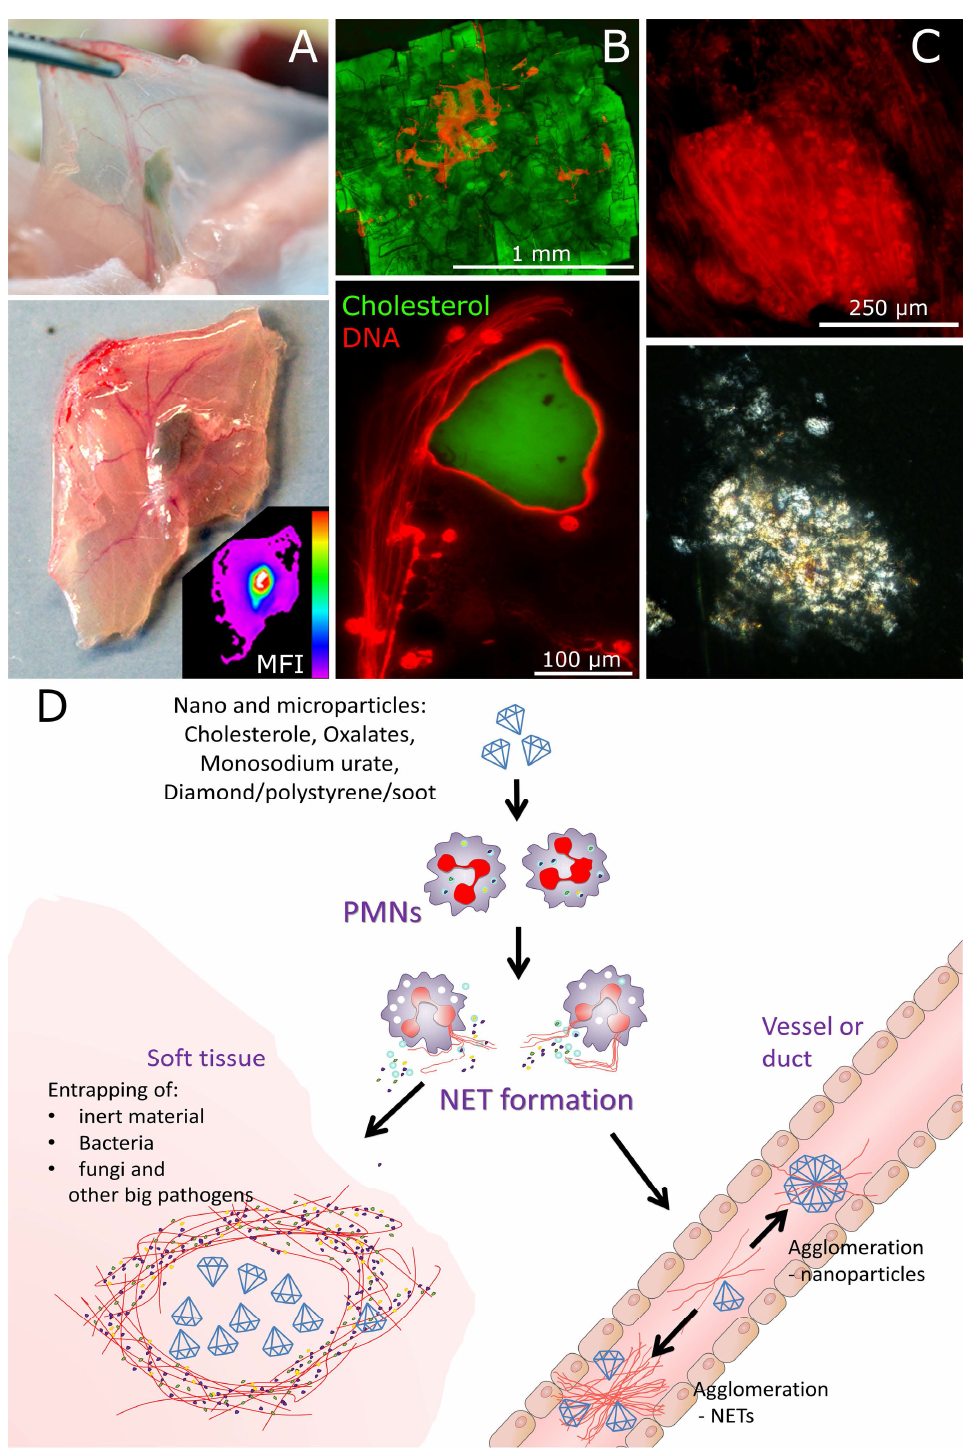
Figure 6. NETs are converting n / µ P to macroaggregates. ( A ) granuloma-like structure, positive with DNA formed around fluorescent nano-diamonds injected into the abdominal cavity of mice, insert demonstrated measure MFI using InVivo Extreme fluorescent imager. Tissue was analyzed 5 days post-injection. ( B ) DNA fibers can be found inside the macroscopic cholesterol crystals, NETs are aggregating cholesterol nanocrystals resulting in the formation of macroaggregates in the ducts and vessels. ( C ) upon injection of cholesterol to air pouch cavities we observed covering of big cholesterol aggregates with NETS (fluorescent and polarizing microscopies). ( D ) schematic representation of possible events leading to either sequestration of n / µ P in soft tissues (left), or formation of aggregates of NETs of n / µ P in ducts and vessels (right).